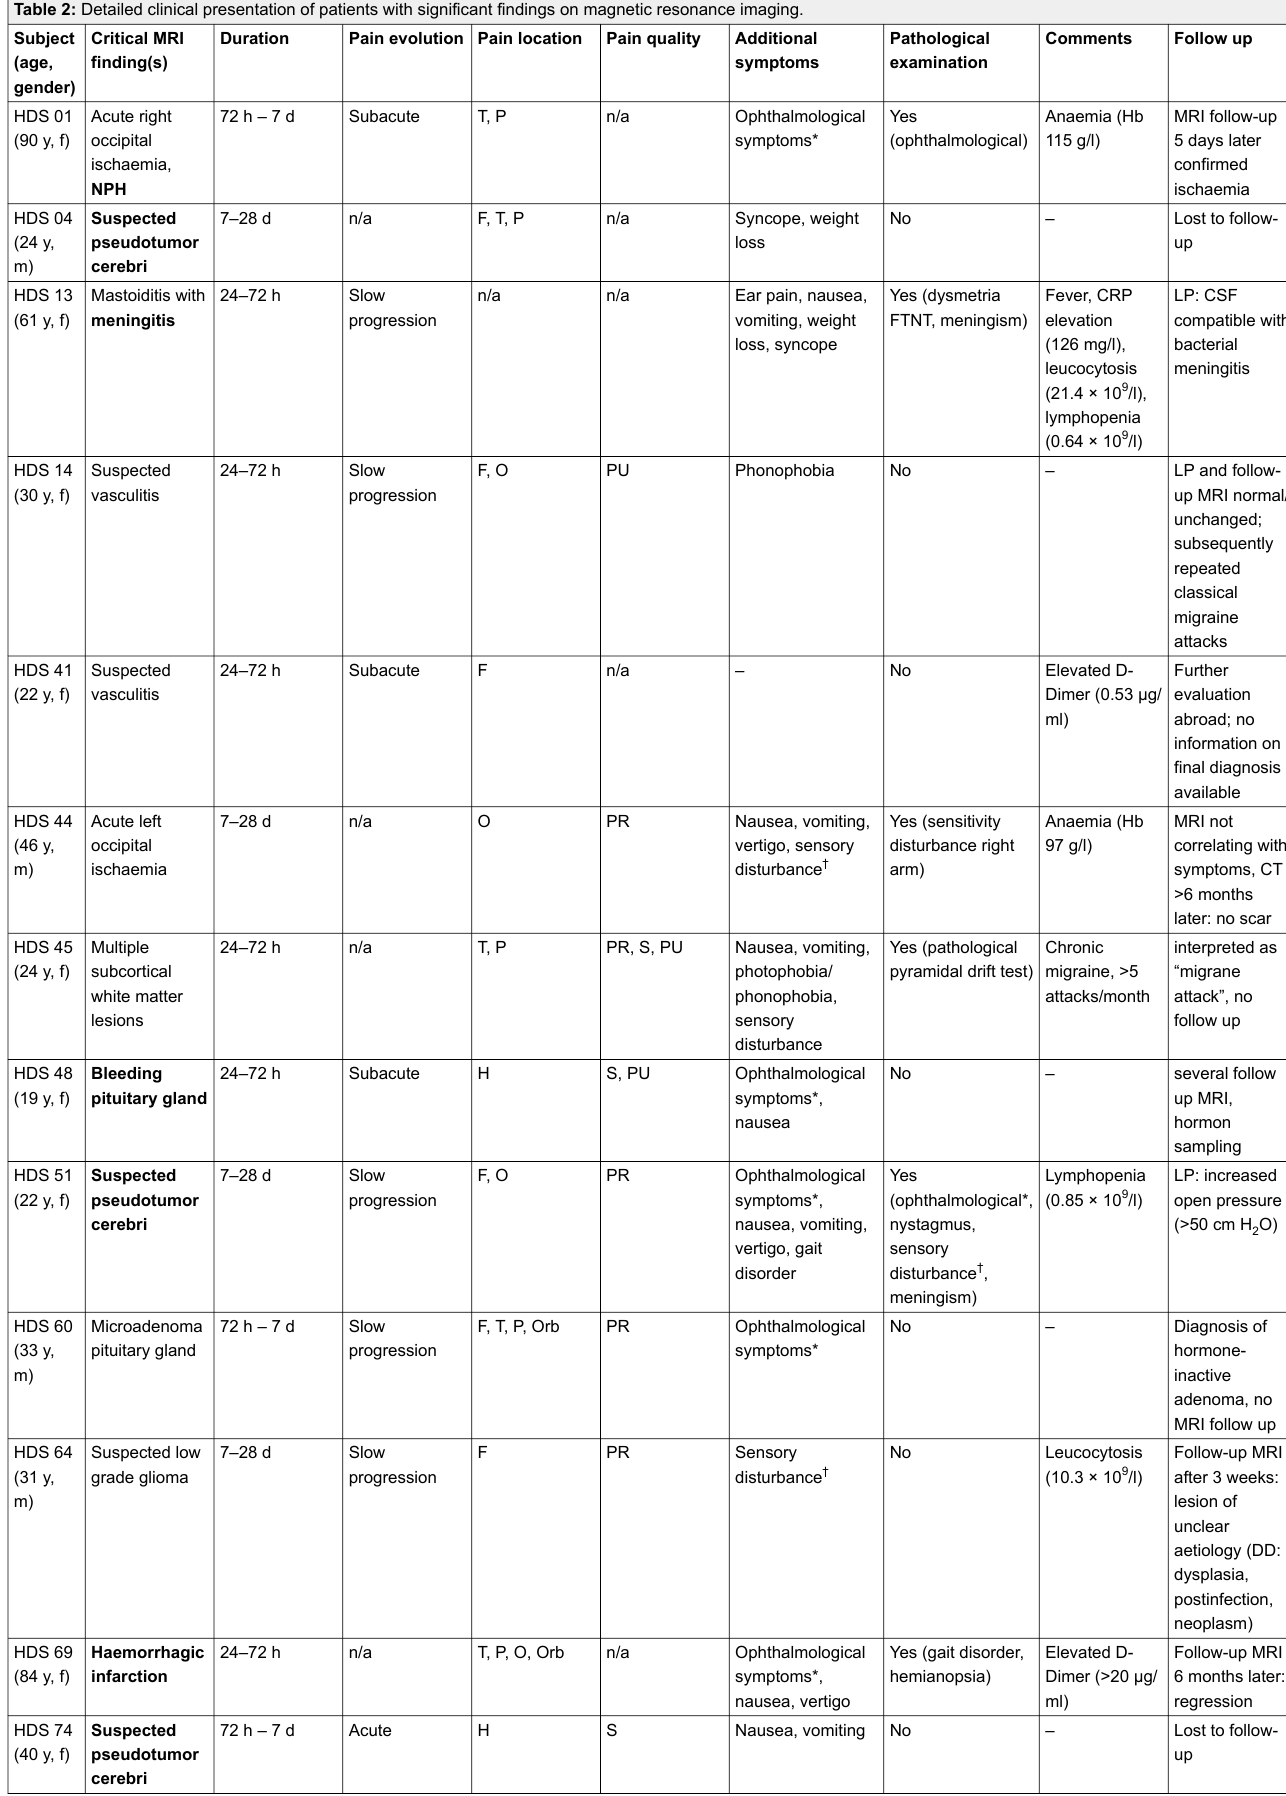
Table 2: Detailed clinical presentation of patients with significant findings on magnetic resonance